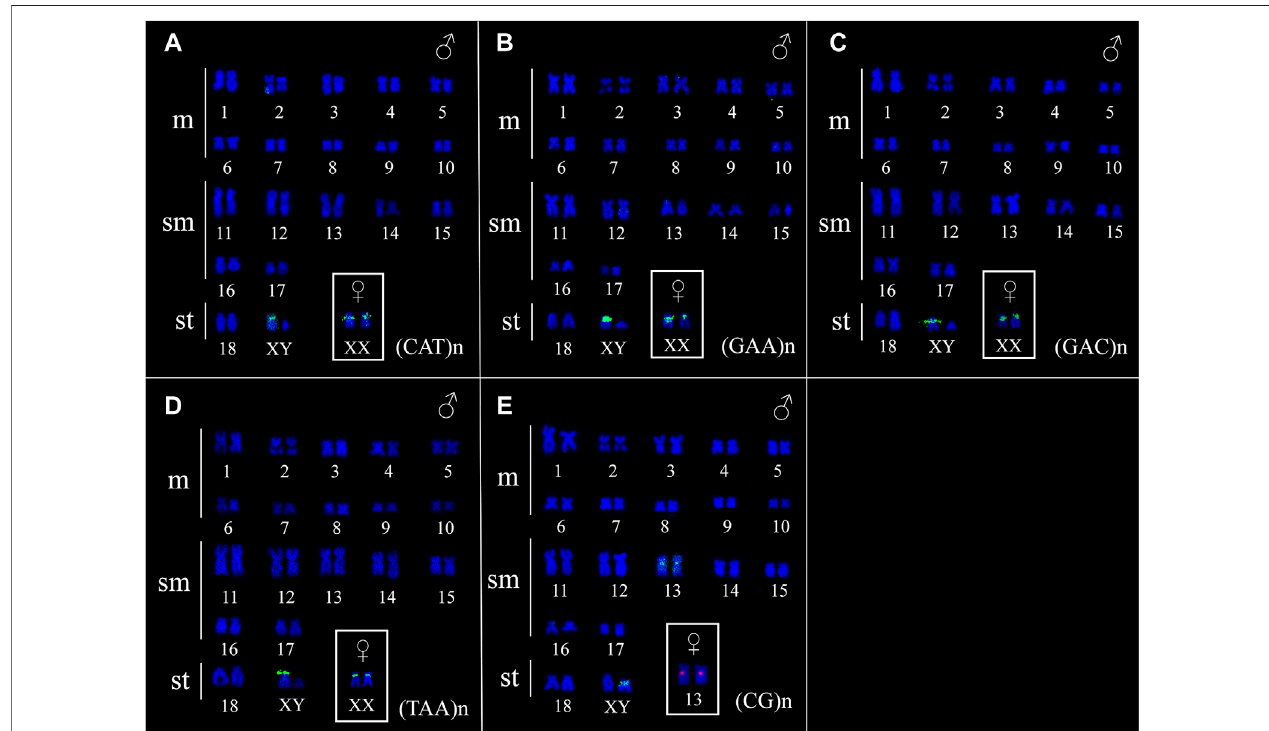
FIGURE4| Fluorescence insitu hybridizationindicatingthephysicallocationofmicrosatellitesequencesinthekaryotypeofAncistrussp.1: (A) (CAT)n, (B) (GAA)n, (C) (GAC)n, (D) (TAA)n, (E) (CG)n. Karyotypes of males are presented; female sex chromosomes are in the boxes. The probes were labeled with FITC (green) and with Cy3 (red), chromosomes were counterstained with DAPI